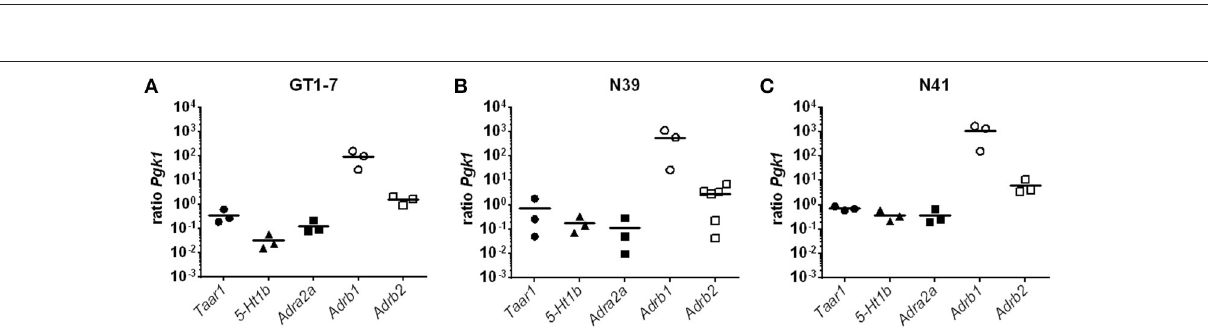
FIGURE 1 | Staining of c-FOS activated neurons after 1h of i.p. injection of 50 mg/kg 3-T 1 AM. After intraperitoneal injection of the C57BL/6J mice with either 3-T 1 AM or solvent (60% DMSO/40% PBS), brains were frozen and cryosectioned and stained against c-FOS and DAPI. ( A ) In comparison to the control mice, 3-T 1 AM-treated mice showed a strong c-FOS staining in the PVN. All pictures were taken with a 20 × objective. ( B ) c-FOS positives cells were counted in the respective nuclei. Only 3-T 1 AM treated animals ( n = 4) showed an increase in c-FOS activity in the PVN. For statistics a two-way ANOVA was performed, followed by a Sidak correction; *** p ≤ 0.001.